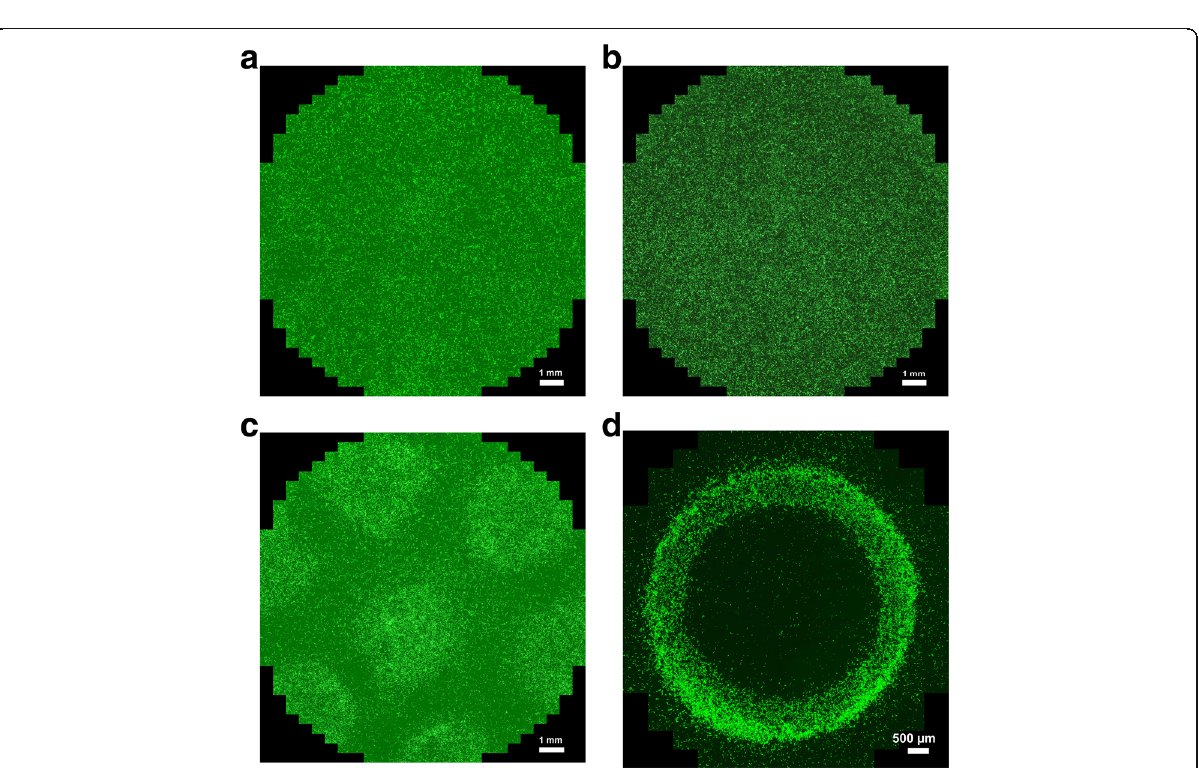
Fig. 4 Guiding of nanoparticle-laden endothelial cells using a magnetic field. The control group shows the spatial distribution of a endothelial cells targeted with nanoparticles and incubated in the absence of magnetic field and b nanoparticle-free endothelial cells incubated in magnetic field. c , d The distribution of endothelial cells targeted with nanoparticles after 1 day of incubation in a magnetic